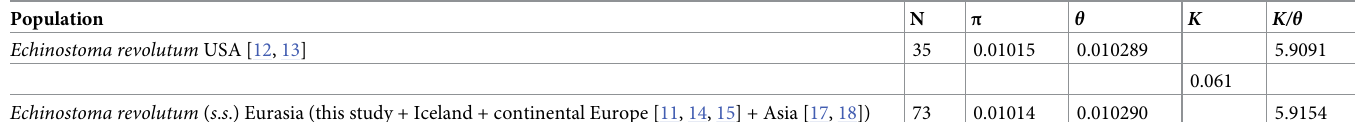
Table 2. Variables associated with Echinostoma revolutum ( sensu lato ) used to test compliance with the K/ θ ratio for speciation.